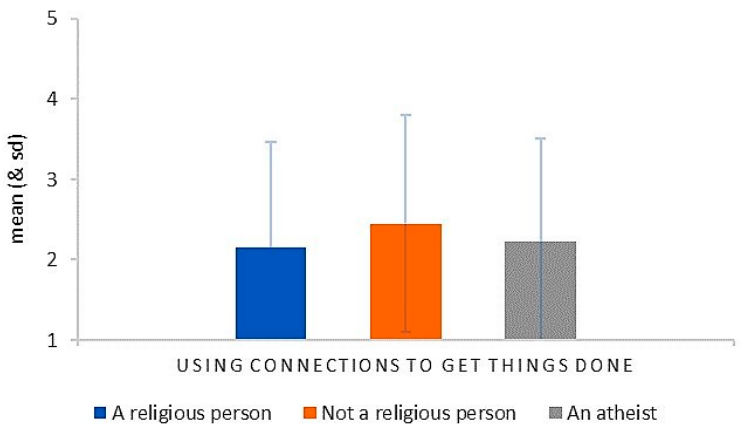
Figure 11. Using connections for getting things done by religious self-declaration. (The error bars represent standard deviation).